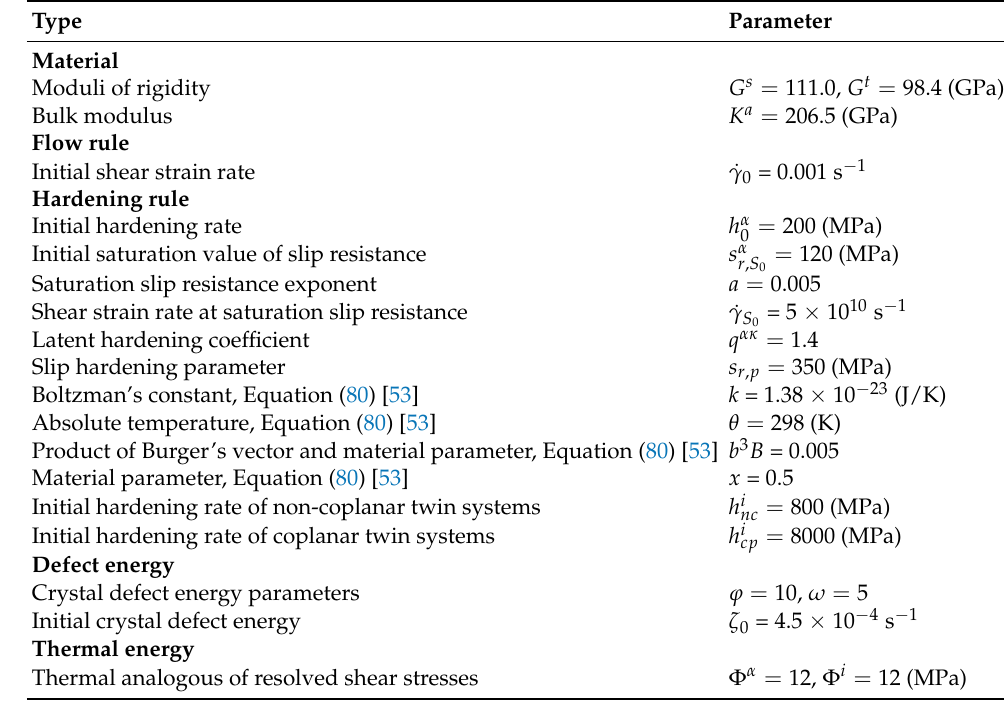
Table 2. General modeling parameters of TWIP